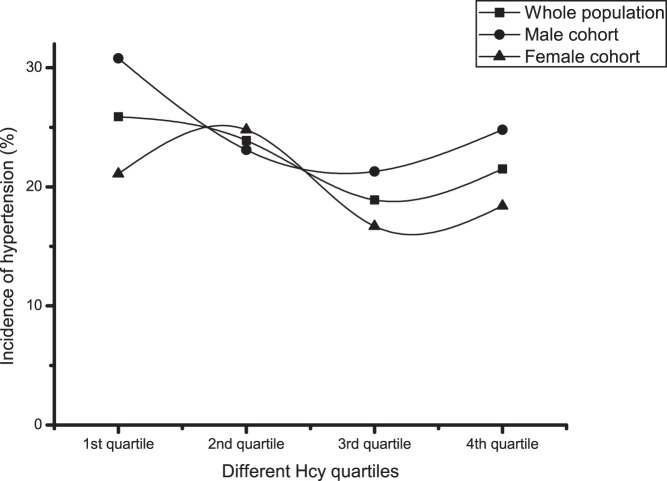
Incidence of hypertension within different Hcy quartiles.Square symbol: Whole population; Circle symbol: Male cohort; Up-triangle symbol: Female cohort.